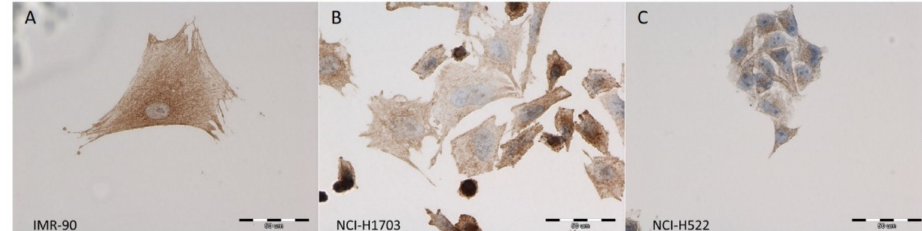
Figure 1. Immunocytochemical (ICC) reactions demonstrating the cytoplasmic localization of ZYX (brown) in the IMR-90 normal lung fibroblast cell line ( A ), NCI-H1703 lung squamous cell carcinoma (SCC) cell line ( B ), and NCI-H522 lung adenocarcinoma (AC) cell line ( C ). Nuclei were counterstained with hematoxylin (blue). Magnification × 400.